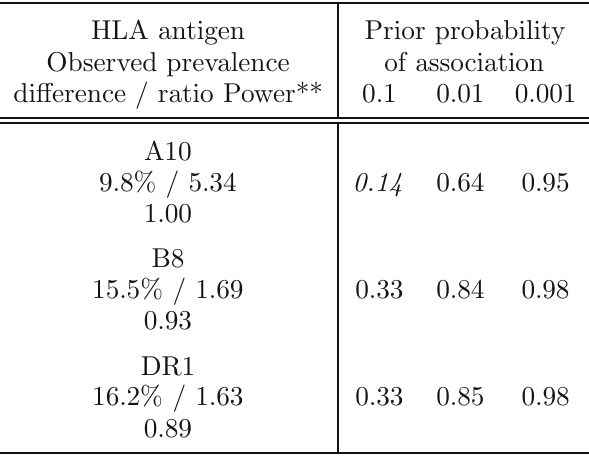
Table 2C False positive report probability (F) values to test the observed statistically significant differences/ratios in the phenotype prevalences of HLA antigens between PSC and PBC patients (reported in Table